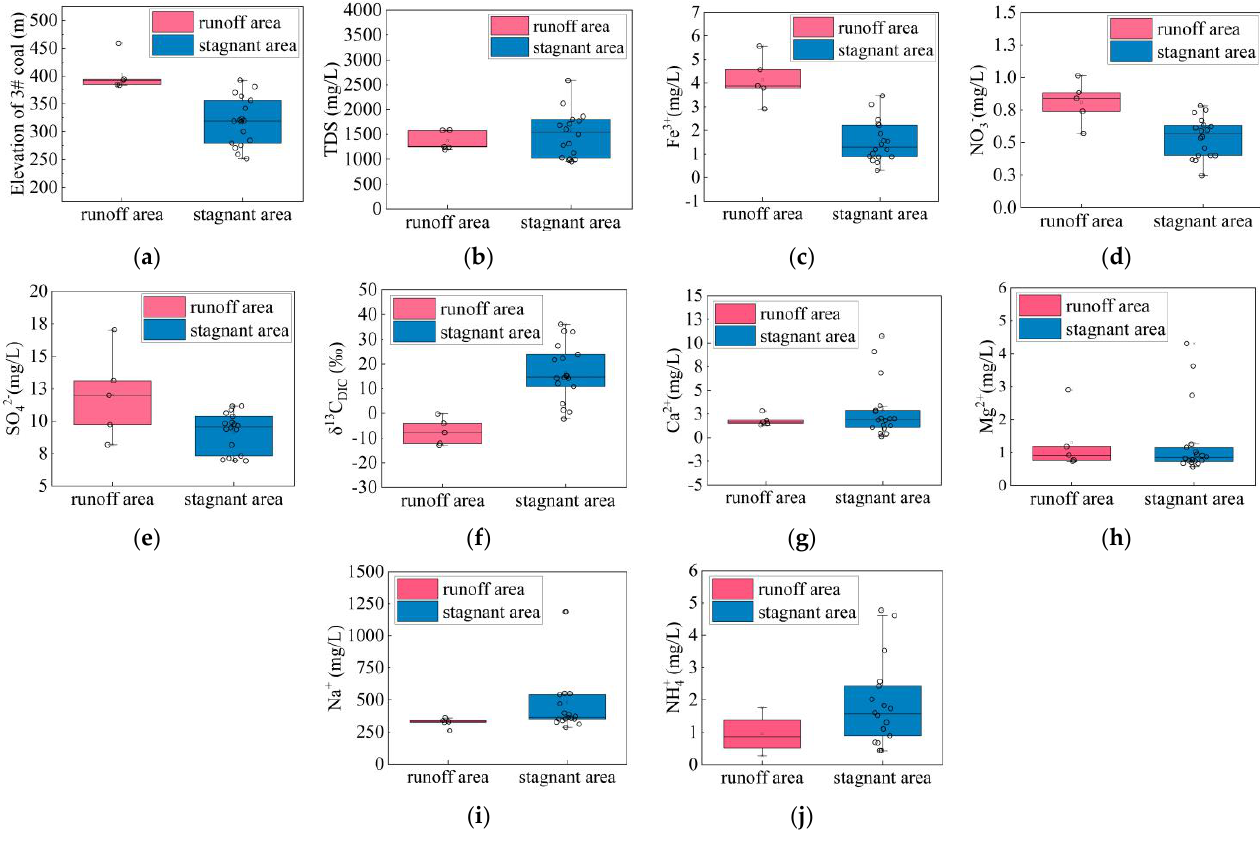
Figure 5. Geochemical characteristics of water ions and gas composition in runoff and stagnant areas: ( a ) #3 coal seam elevation (m); ( b ) TDS (mg/L); ( c ) Fe 3+ (mg/L); ( d ) NO 3 − (mg/L); ( e ) SO 42 − (mg/L); ( f ) δ 13 C DIC (‰); ( g ) Ca 2+ (mg/L); ( h ) Mg 2+ (mg/L); ( i ) Na + (mg/L); ( j ) NH 4+ (mg/L).